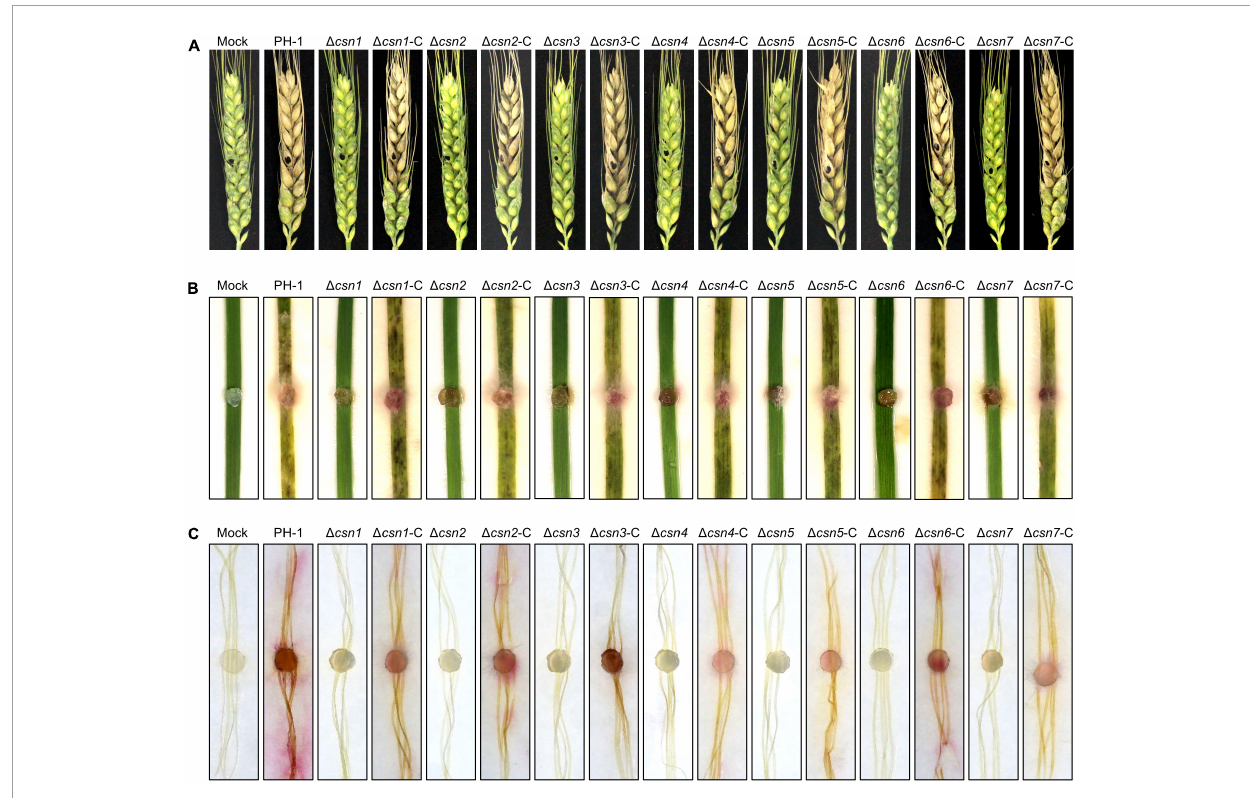
FIGURE8 The Csn complex is necessary for F. graminearum virulence. (A) Flowering wheat heads were inoculated with mycelial plugs from the indicated strains, and photos were taken 14 days post-inoculation (dpi). The mycelial plugs of the indicated strains were used to inoculate wheat leaves (B) and corn silks (C) , and disease symptoms were recorded after 7 dpi.